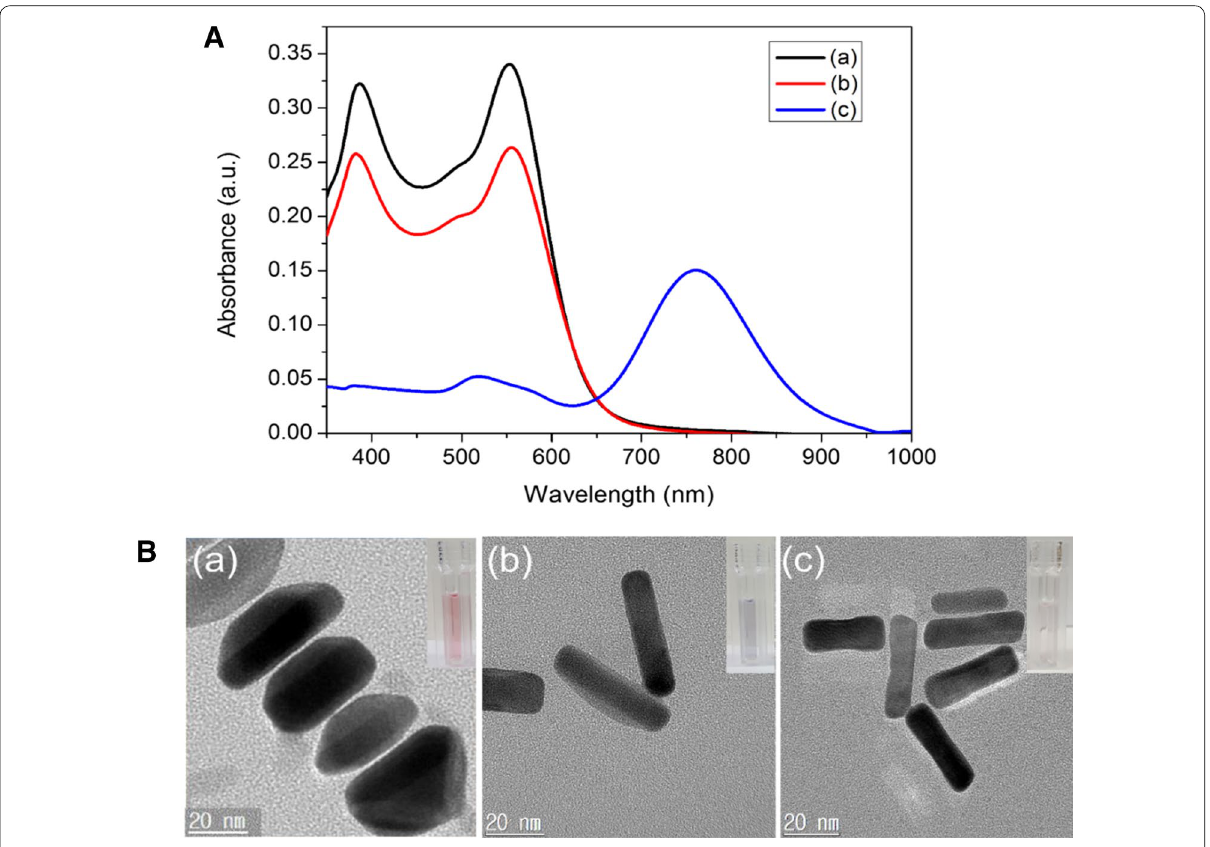
Fig. 3 A UV–vis absorption spectra and B HR-TEM images of: (a) original AuNR@Ag-1 (b) AuNR@Ag after reacted with 10 μM of Cr(VI) and (c) AuNR@Ag after reacted with 60 μM of Cr(VI). (Insets: photographs of each AuNR@Ag colloid solutions)